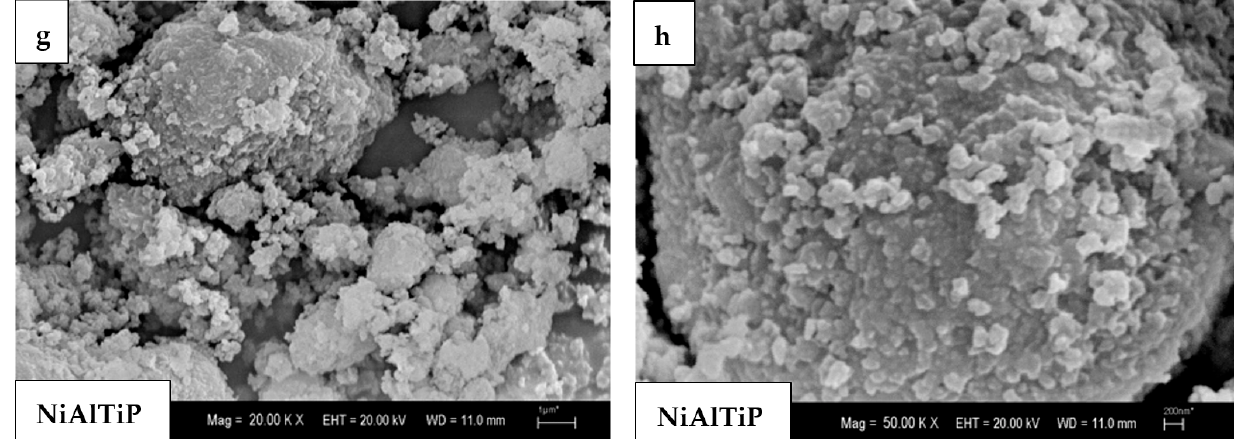
Figure 4. Scanning electron microscopy of Mn 0.5 Ti 2 (PO 4 ) 3 (MnTiP), Mn 0.6 Al 0.2 Ti 1.8 (PO 4 ) 3 (MnAlTiP), Ni 0.5 Ti 2 (PO 4 ) 3 (NiTiP), Ni 0.6 Al 0.2 Ti 1.8 (PO 4 ) 3 (NiAlTiP).